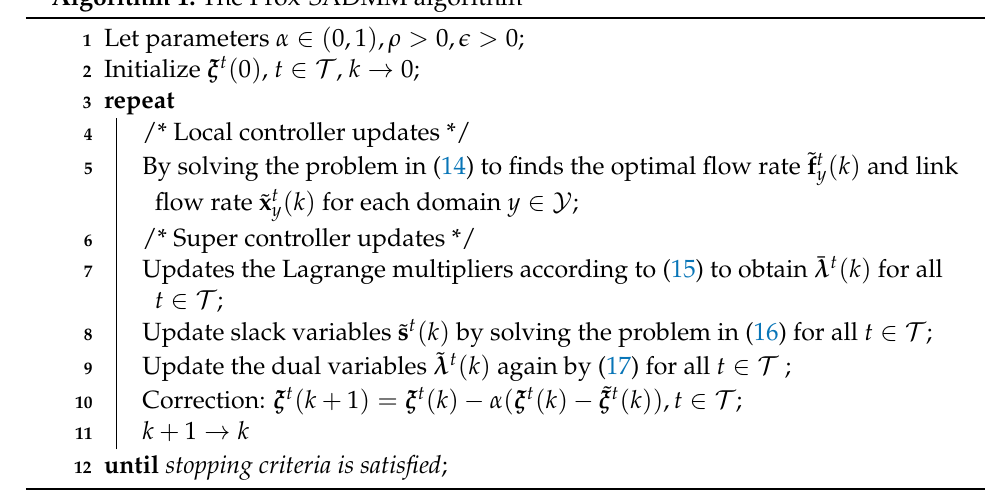
Algorithm 1: The Prox-SADMM algorithm